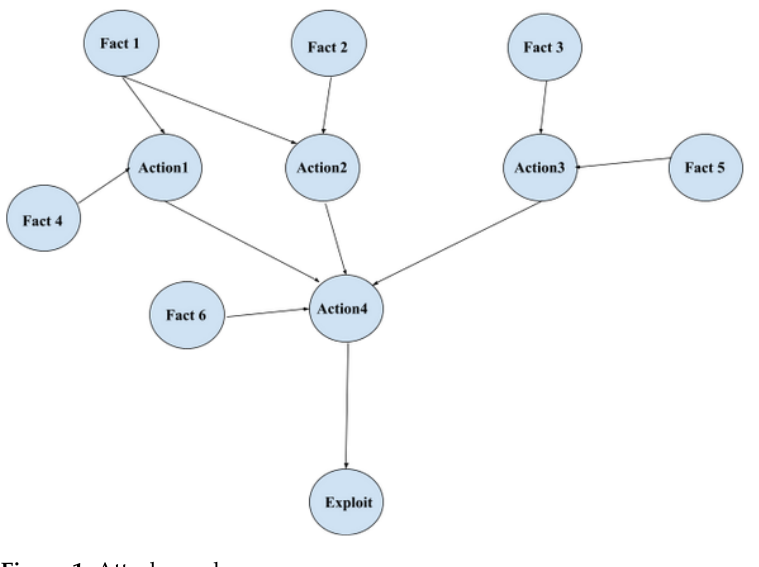
Figure 1. Attack